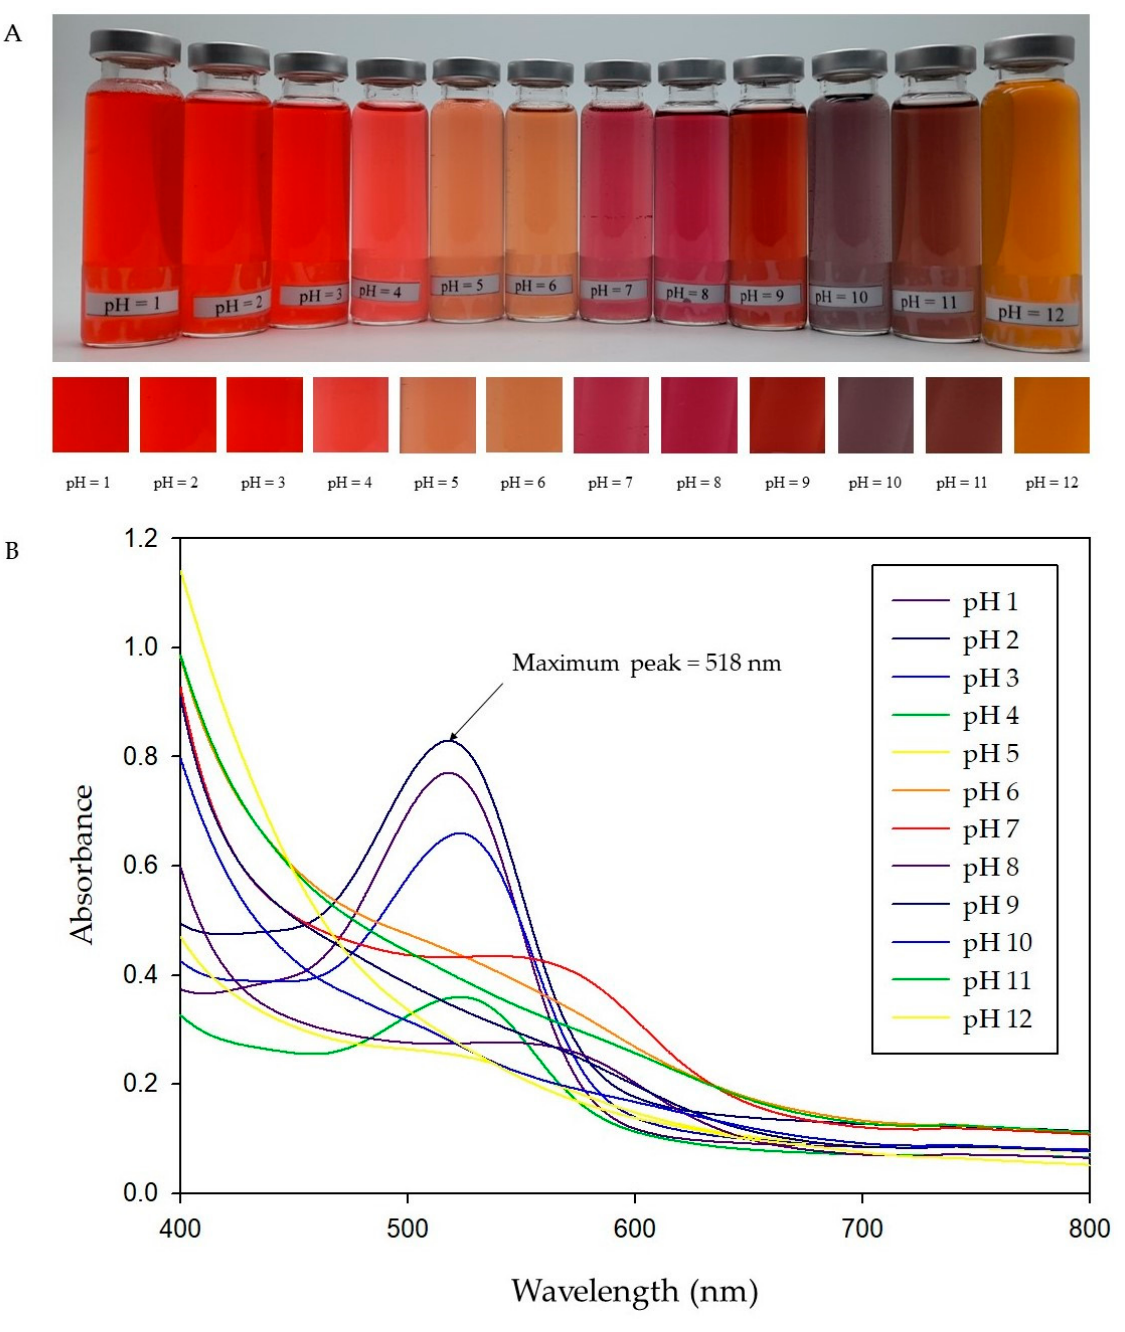
Figure 5. Changes in colors of RA solution ( A ) and UV–vis spectra of RA solutions in the pH range of 1–12 ( B ).